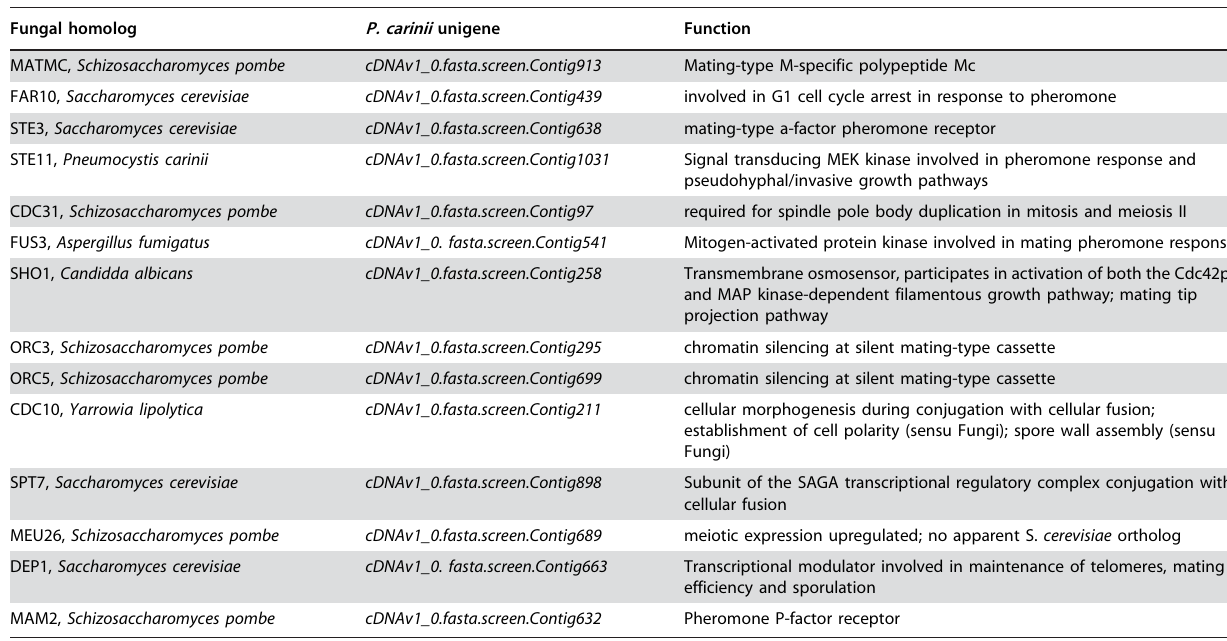
Table 6. Gene Homologs associated with mating/meiosis. .. ... .... ... ... .... ... ... .... ... ... .... ... ... .... ... ... .... ... ... .... ... ... .... ... ... .... ... ... .... ... ... .... ... ... .... ... ... .... ... ... .... ... ...